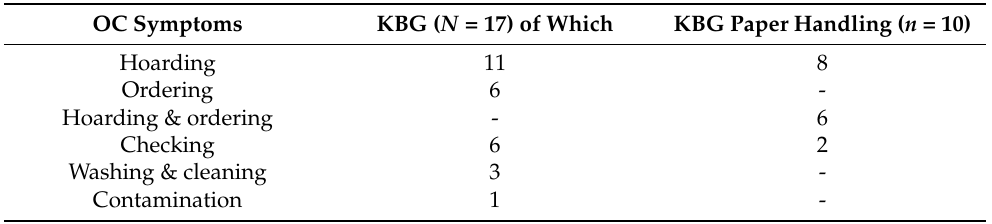
Table 1. Obsessive compulsive symptoms and “paper handling” activities in 17 KBGS (KBG syn- drome) subjects; OC = obsessive-compulsive. OC Symptoms KBG ( N = 17) of Which KBG Paper Handling ( n = 10) 11